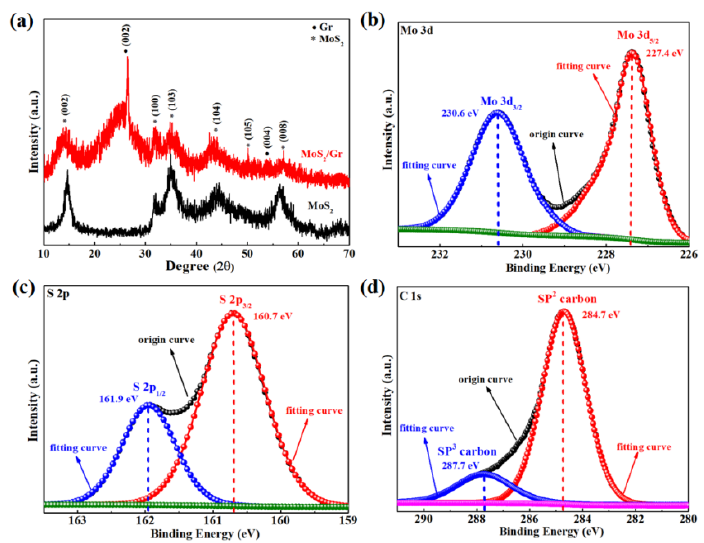
Figure 1. ( a ) XRD pattern of the pristine MoS 2 and MoS 2 /Gr heterostructure. ( b – d ) High-resolution Mo 3d, S 2p, and C 1s XPS data, respectively.